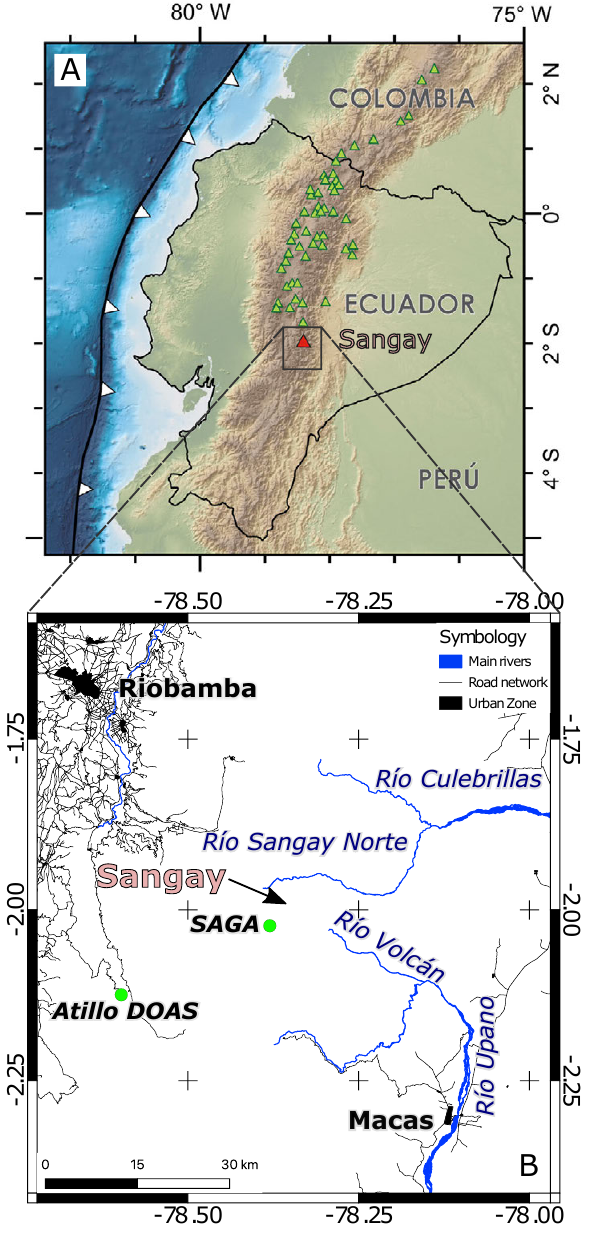
Figure 1: [A] Location of Sangay volcano in the Ecuadorian vol- canic arc; [B] Monitoring instruments (green dots), main rivers (in blue) and populated areas are represented as black